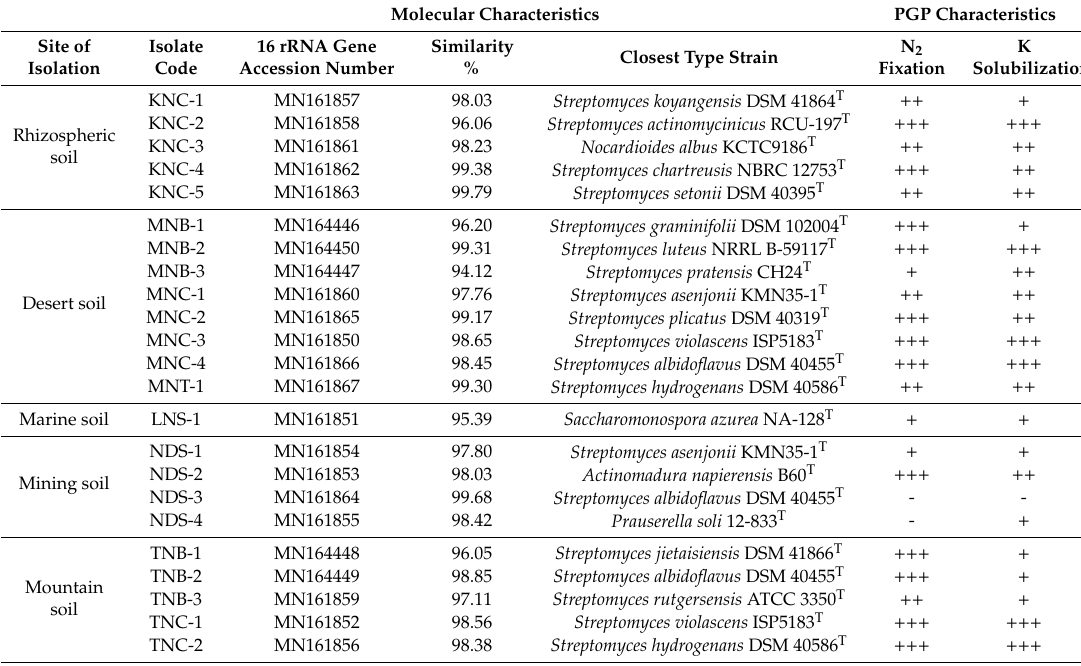
Table 2. Molecular and plant growth-promoting (PGP) characteristics of the isolated actinobacteria. Molecular